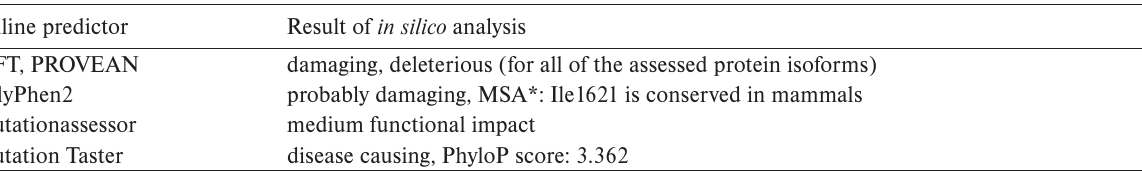
Table 1. Result of in silico analysis of novel TSC2 mutation functional effect.